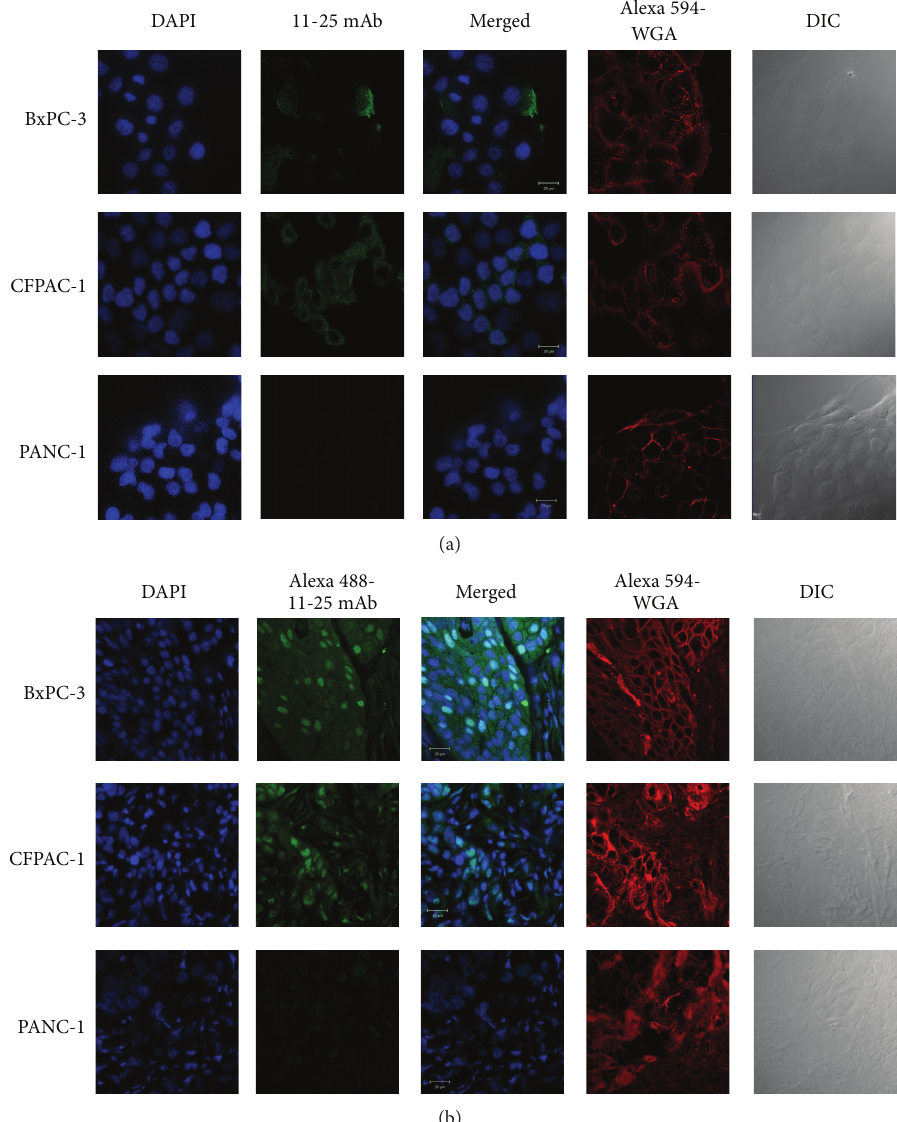
Figure 2: Immunohistochemical analysis of MSLN expression. (a) Expression of MSLN protein in cultured cancer cells detected by immunocytochemistry. BxPC-3, CFPAC-1, and PANC-1 cells were plated in 8-well chamber slides, cultured for 3 days, and incubated with 11-25 mAb followed by treatment with FITC-labeled anti-mouse IgG, Alexa Fluor 594-labeled wheat germ agglutinin (WGA), and DAPI. (b) Expression of MSLN in xenografts. Frozen sections of tumors derived from BxPC-3, CFPAC-1, and PANC-1 were treated with Alexa Fluor 488-labeled 11-25 mAb, Alexa Fluor 594-WGA, and DAPI. Bar: 20 𝜇